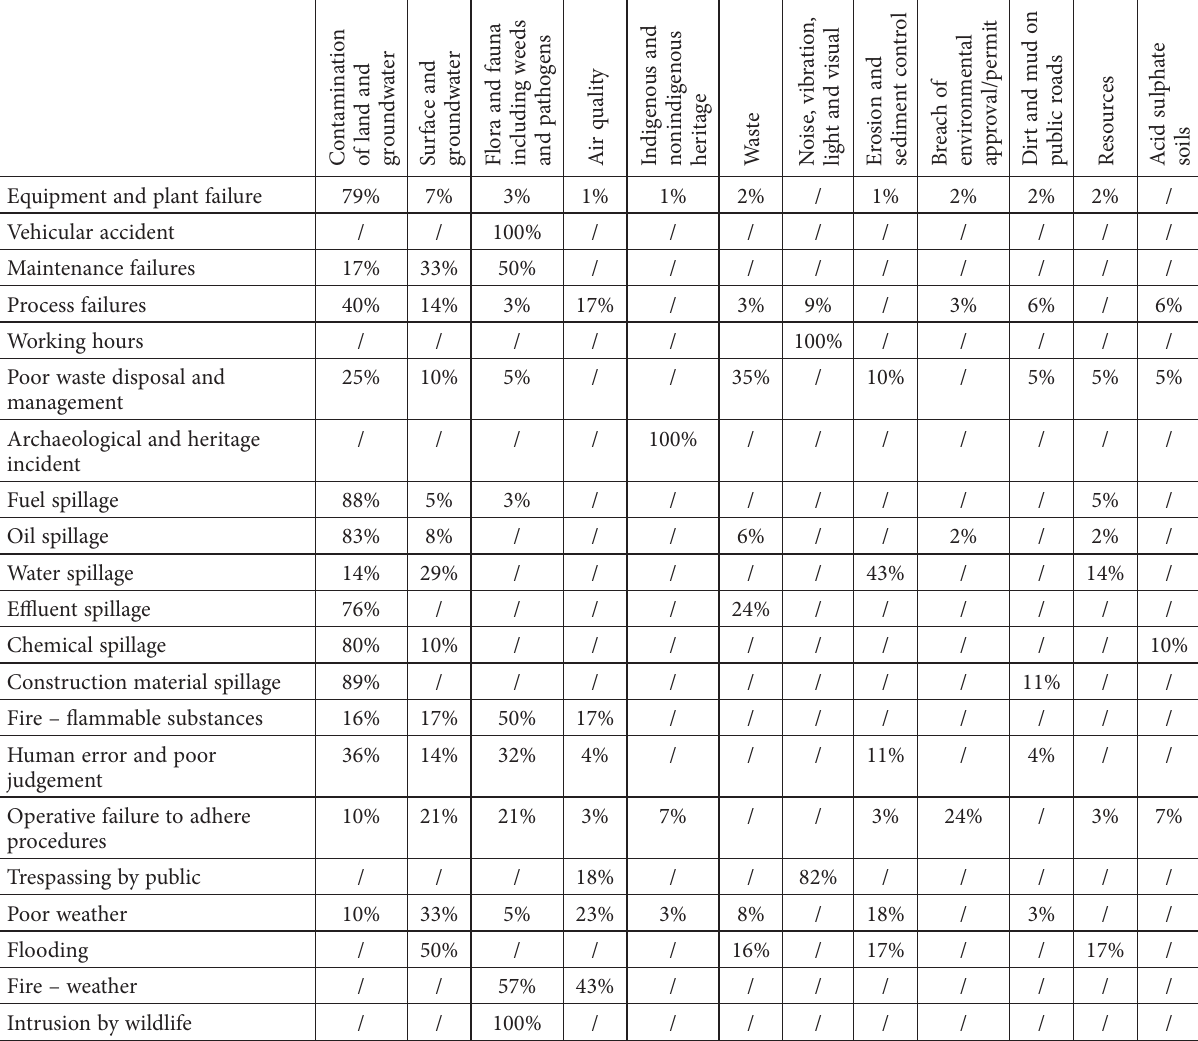
Table 7. The relationship between the causes of incidents and environment